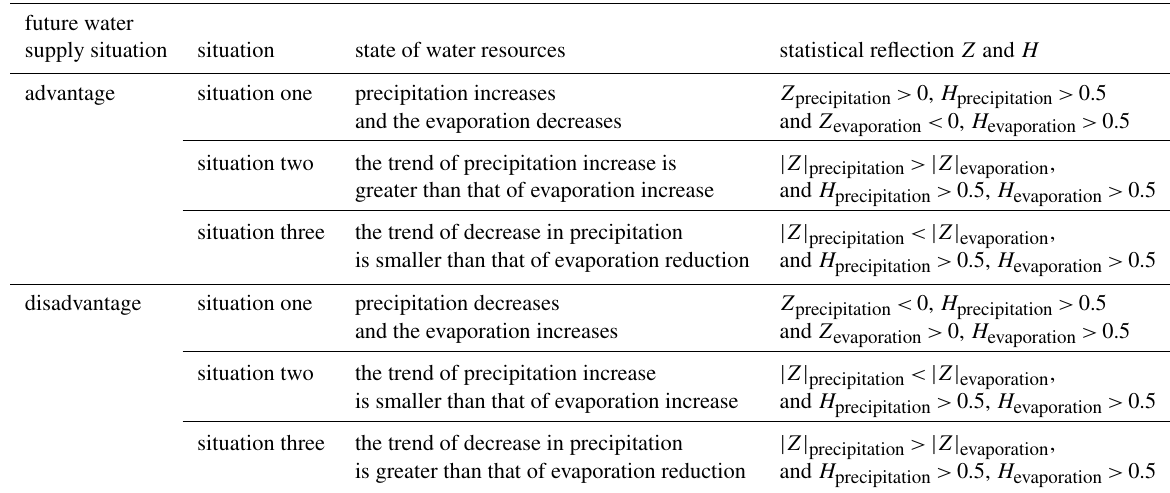
Table 3. Situations of regional future water